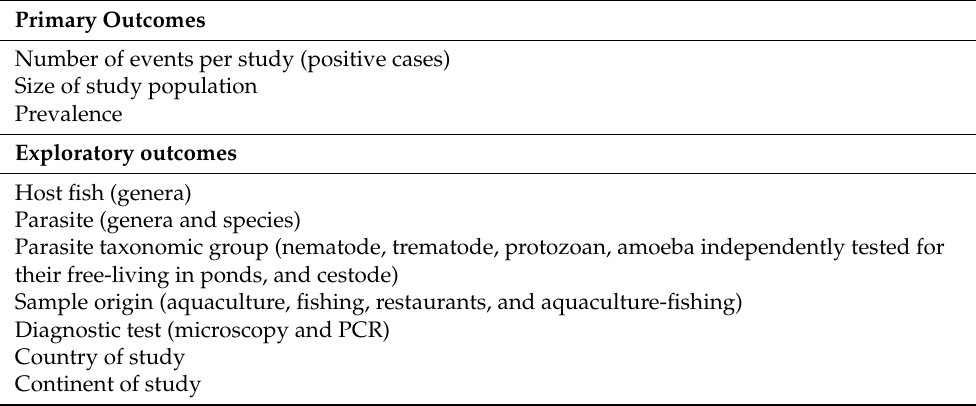
Table 2. Data variables extracted from studies included in the